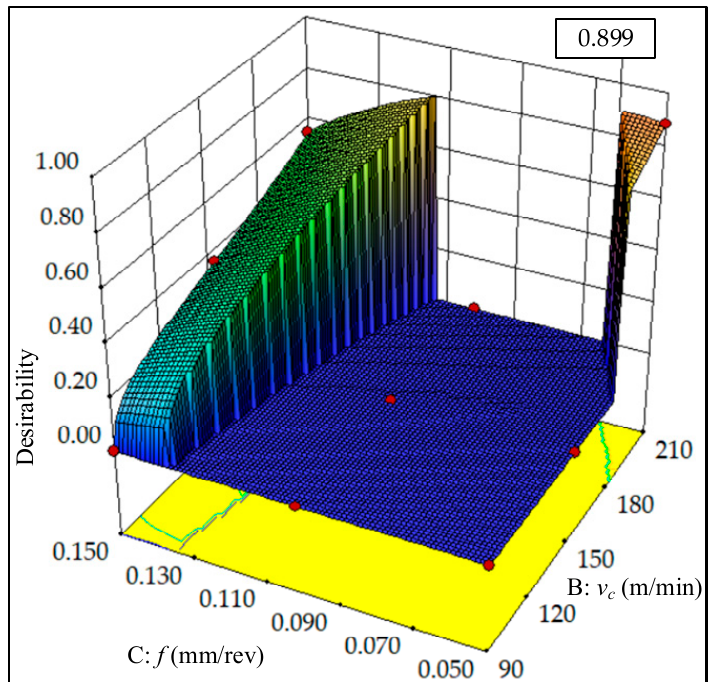
Figure 17. Ramp function graph of desirability (LSR mode) .